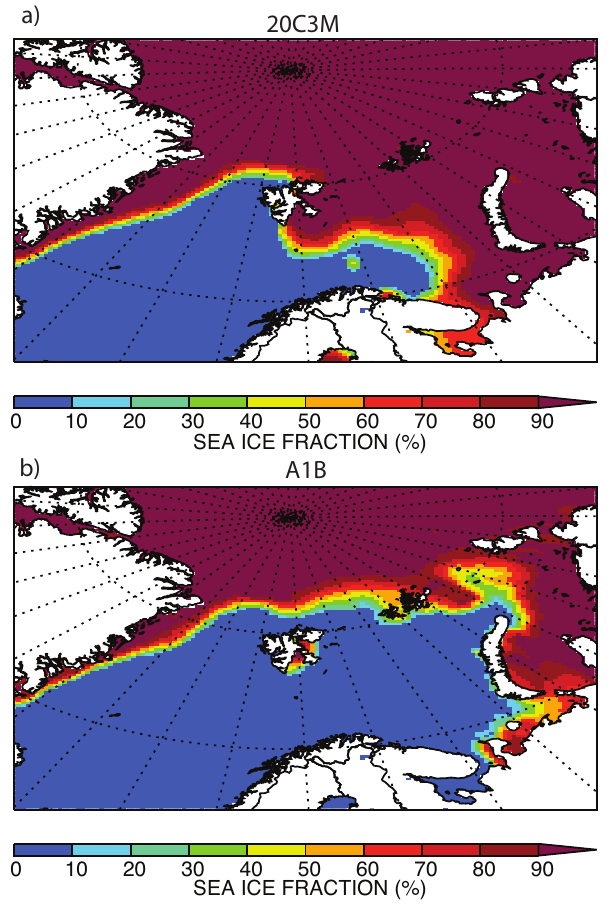
Fig. 7. March (maximum) mean sea ice concentration for (a) , 20C3M experiment and (b) A1B experiment. Interpolated onto the 0.22 ◦ RCM grid from the HadGEM1 CMIP3